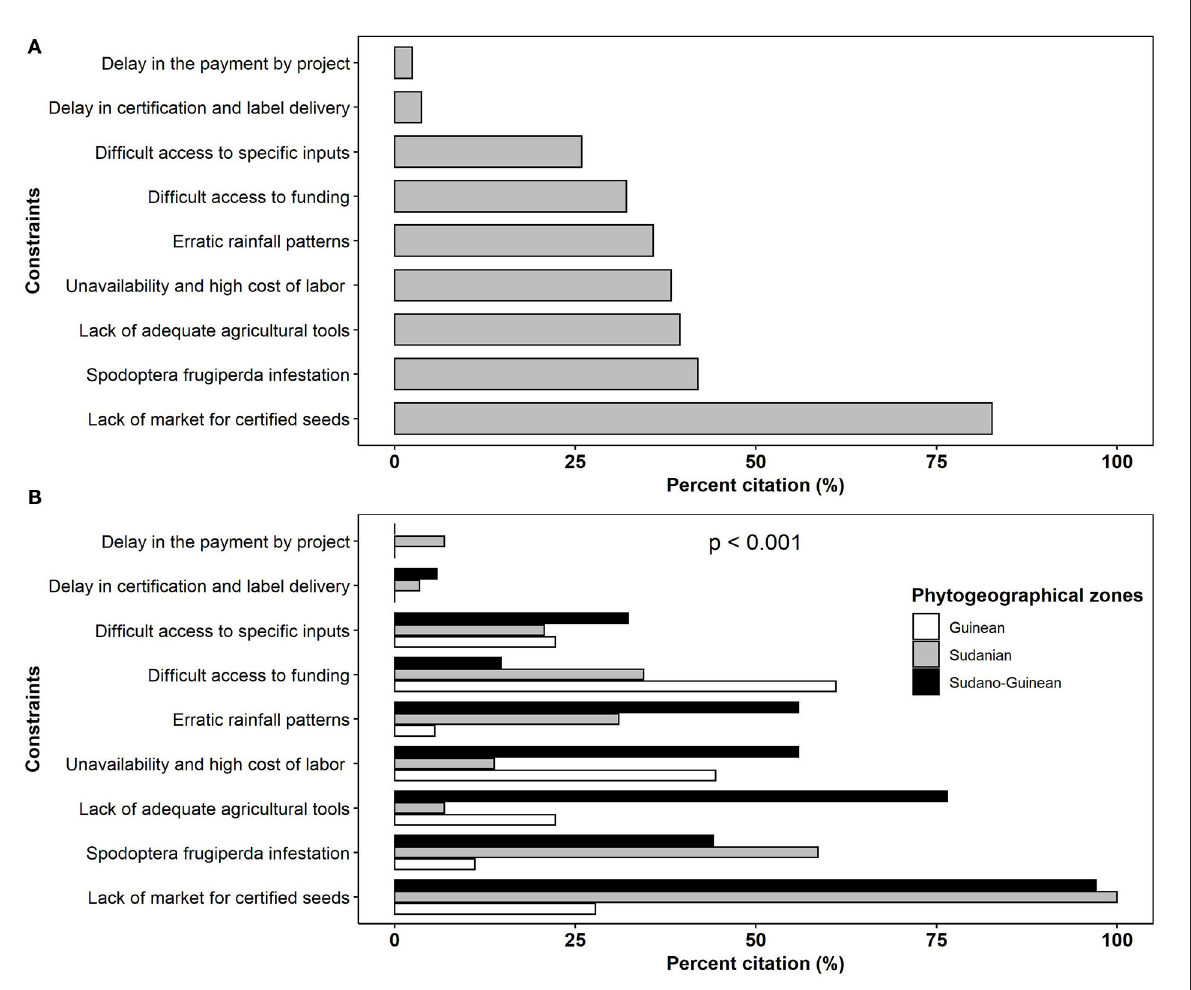
(Figure 7A). The importance of the constraints differs across phytogeographical zones (Figure 7B, Fisher’s exact p < 0.001). The difficult access to funding, unavailability and high cost of labor, and unavailability of specific inputs (fertilizers and pesticides) for production were mostly cited by producers in the Guinean zone. Producers from Sudano-Guinean zones highlighted the lack of adequate agricultural tools for production and post-harvest activities, high cost and unavailability of labor, erratic rainfall patterns and S. frugiperda attacks. Sudanian zone farmers identified S. frugiperda infestation as the major constraint, followed by difficult access to funding for production and erratic rainfall